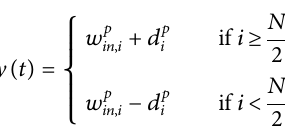
Frontiers in Arti fi cial Intelligence |